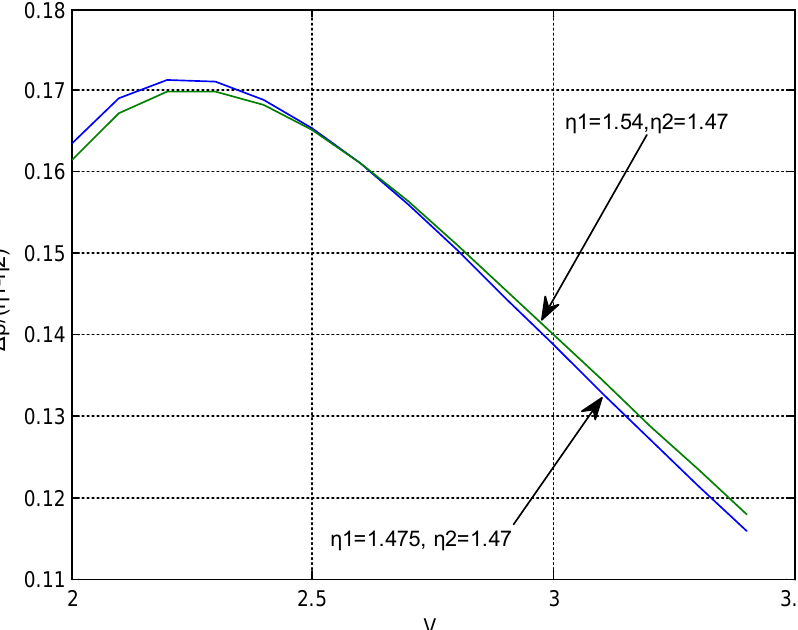
Figure 4. Normalized birefringence of two step-index fibers with different refractive indexes as functions of their parameters V.